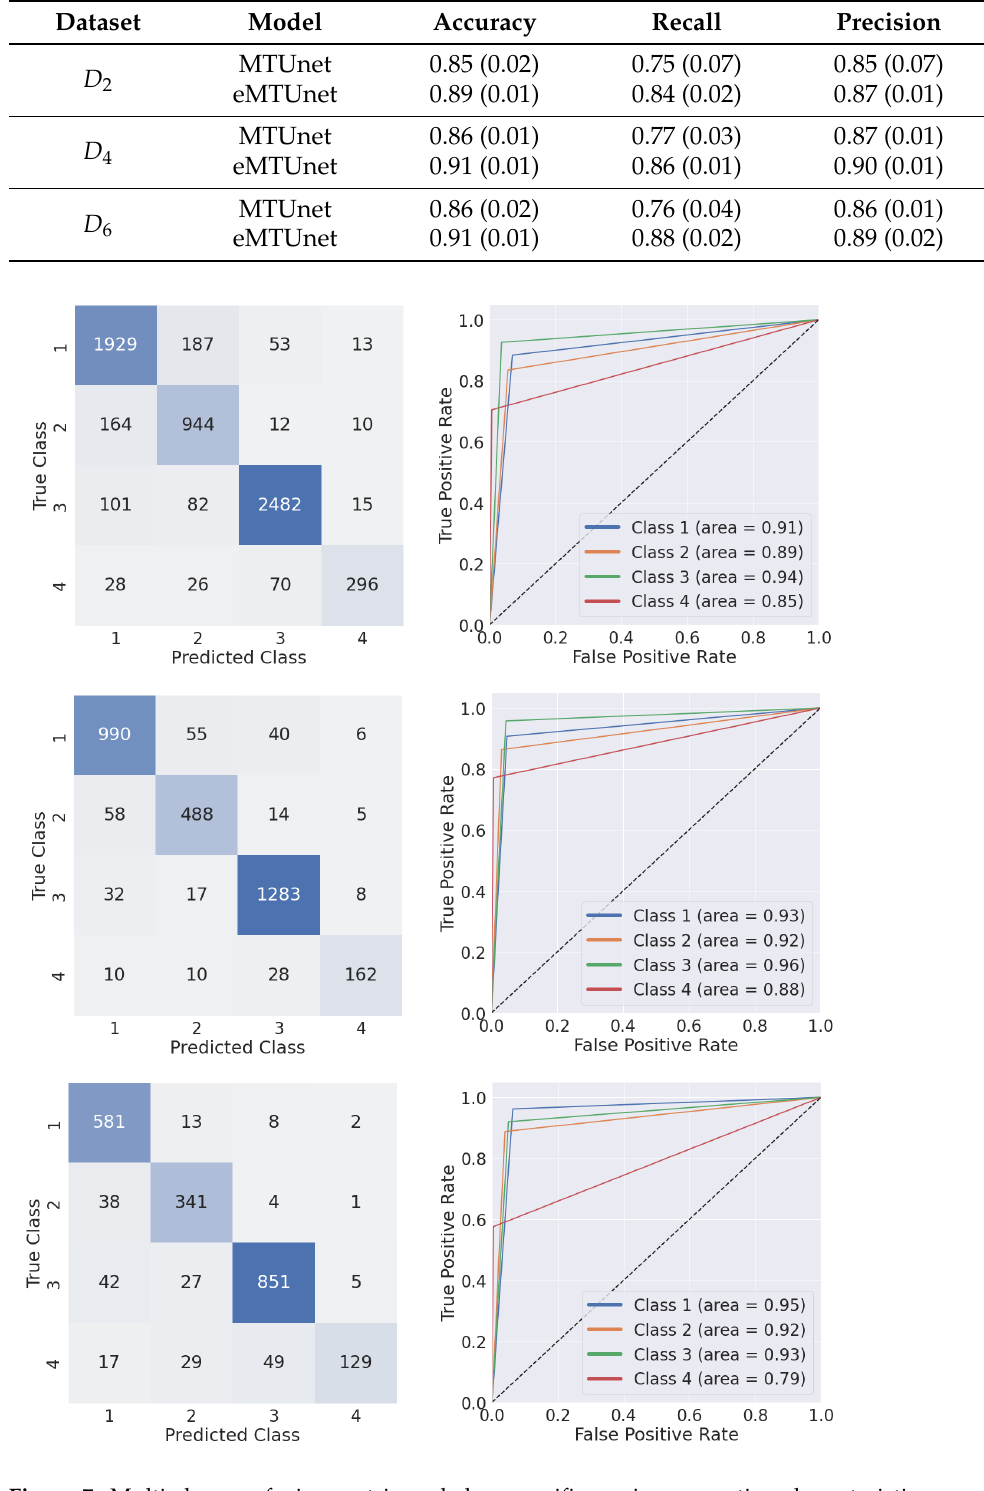
Table 4. Comparison of metrics performances for eMTUnet and MTUnet. Accuracy, recall, and preci- sion are computed for classification task. Each value was evaluated with a ten-fold cross-validation on both D 2 , D 4 , and D 6 .